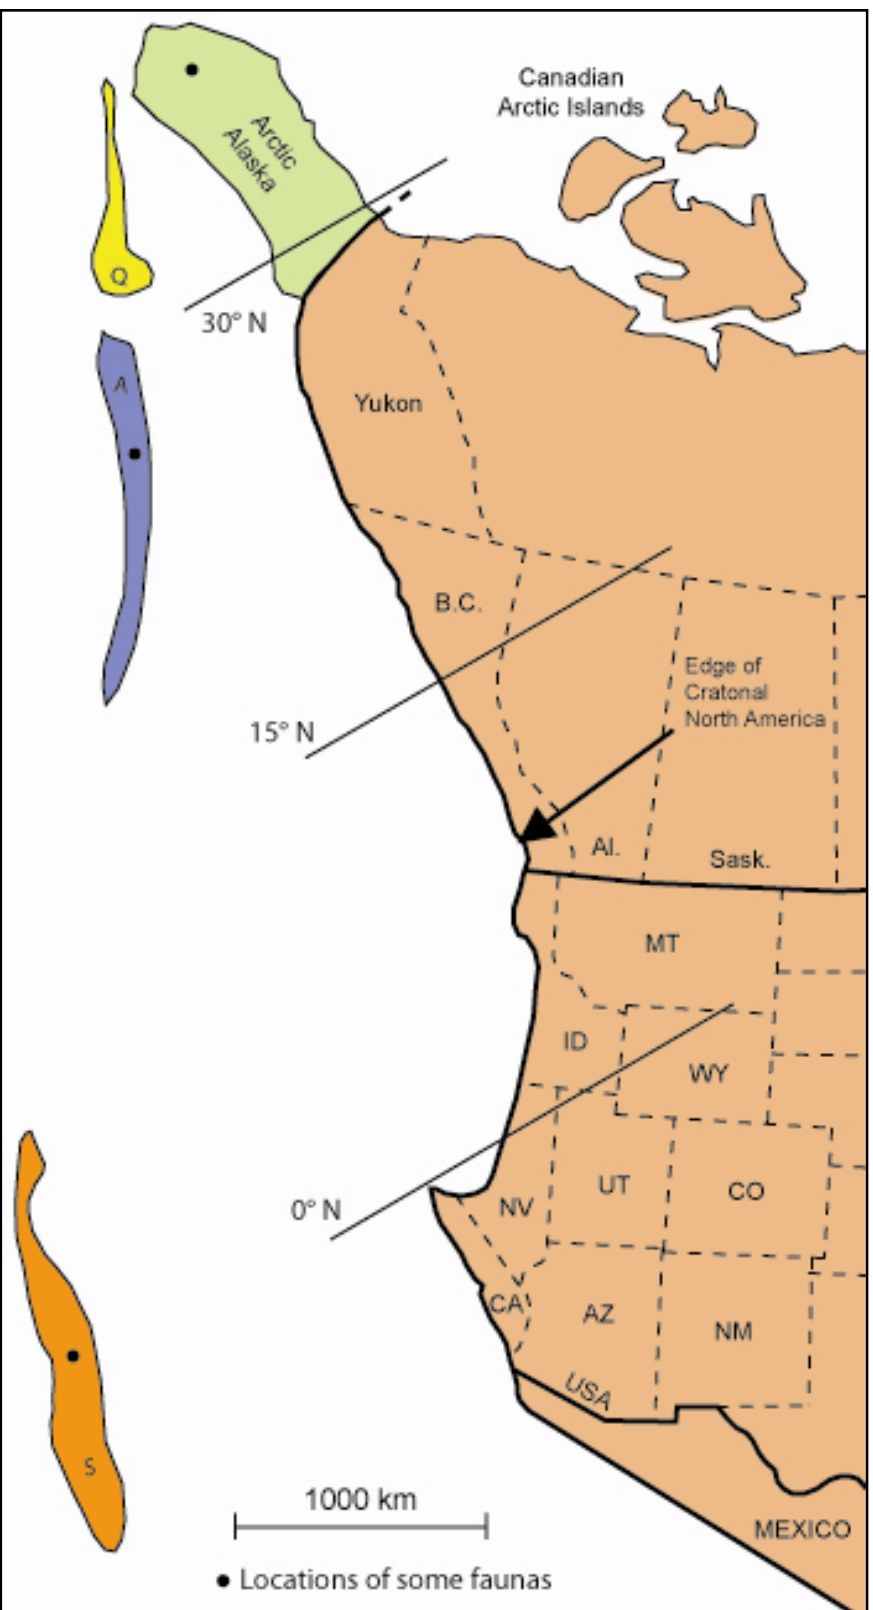
Figure 2. Interpreted Mississippian position of allochthonous terranes. A = Alexander; Q = Quesnellia; S = Stikine terranes. Paleolatitudes for cratonal North America are from Scotese and McKerrow